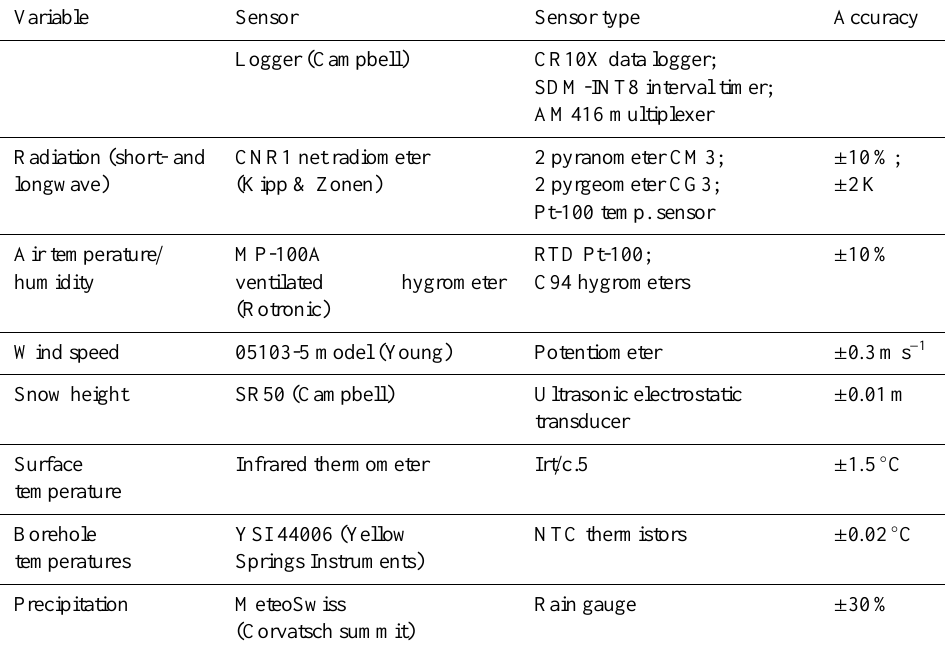
Table 1. Meteorological station equipment and accuracy.